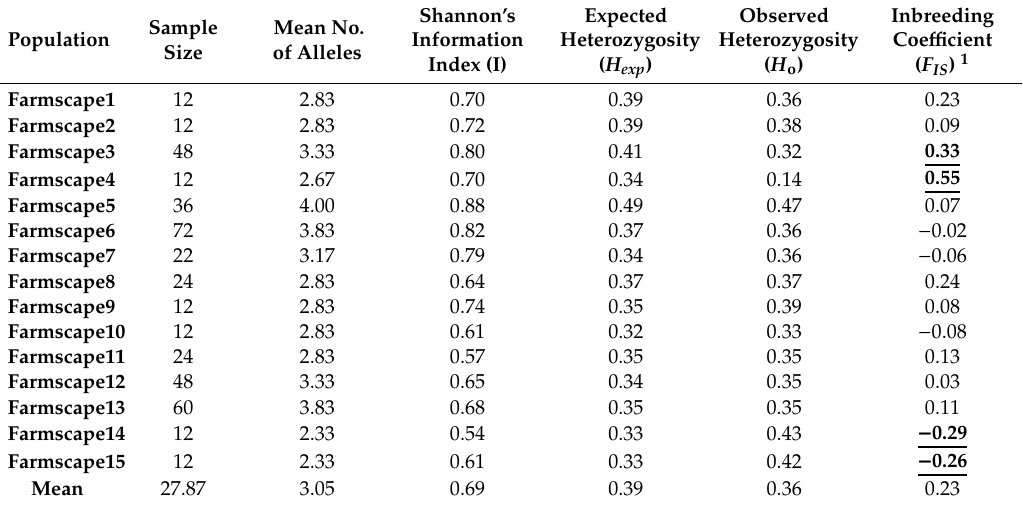
Table 4. Genetic diversity of B. tabaci MEAM1 populations collected from di ff erent farmscapes based on six microsatellites markers.